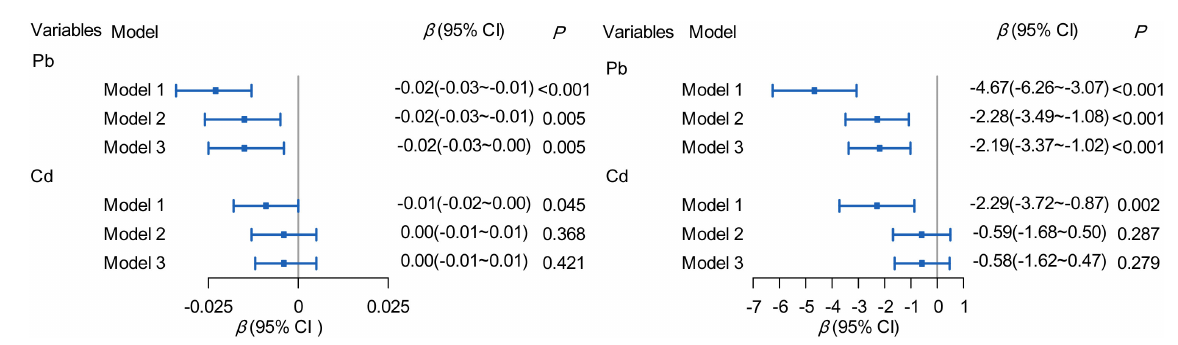
FIGURE6 Association of ADDs [ µ g/(kg · d)] of Pb/Cd with WHR and WC. Model 1: The adjusted for per capita monthly income, sex, age, education level and marital status. Model 2: The adjusted for smoking, drinking, T2DM, hypertension, weekly exercise times, grade of BMI, and weekly intake of fresh vegetables/fruits, anxiety or depression state and stillness and sitting time. Model 3: The adjusted for the covariates in Model 1 and Model 2. Pb, Total intake of Pb; Cd, Total intake of